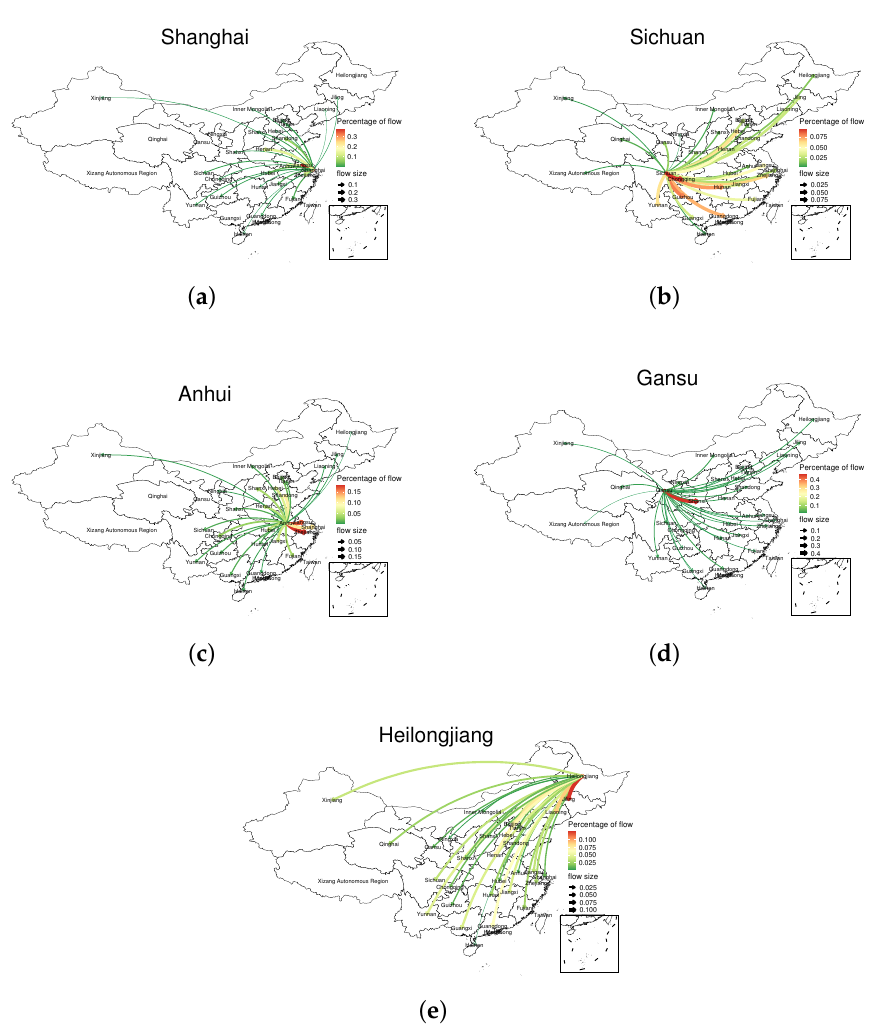
Figure 7. Travel flow map. The color of the arrow indicates the amount of passenger flow. Red indicates high passenger flow, and green indicates low passenger flow. The arrow also indicates the direction of passenger flow and the thickness of it corresponds to the amount of the flow. Note: all passenger flows are converted into percentage form, and the value range is from 0 to 1. ( a ) Passenger flow from Shanghai to other provinces. ( b ) Passenger flow from Sichuan to other provinces. ( c ) Passenger flow from Anhui to other provinces. ( d ) Passenger flow from Gansu to other provinces. ( e ) Passenger flow from Heilongjiang to other